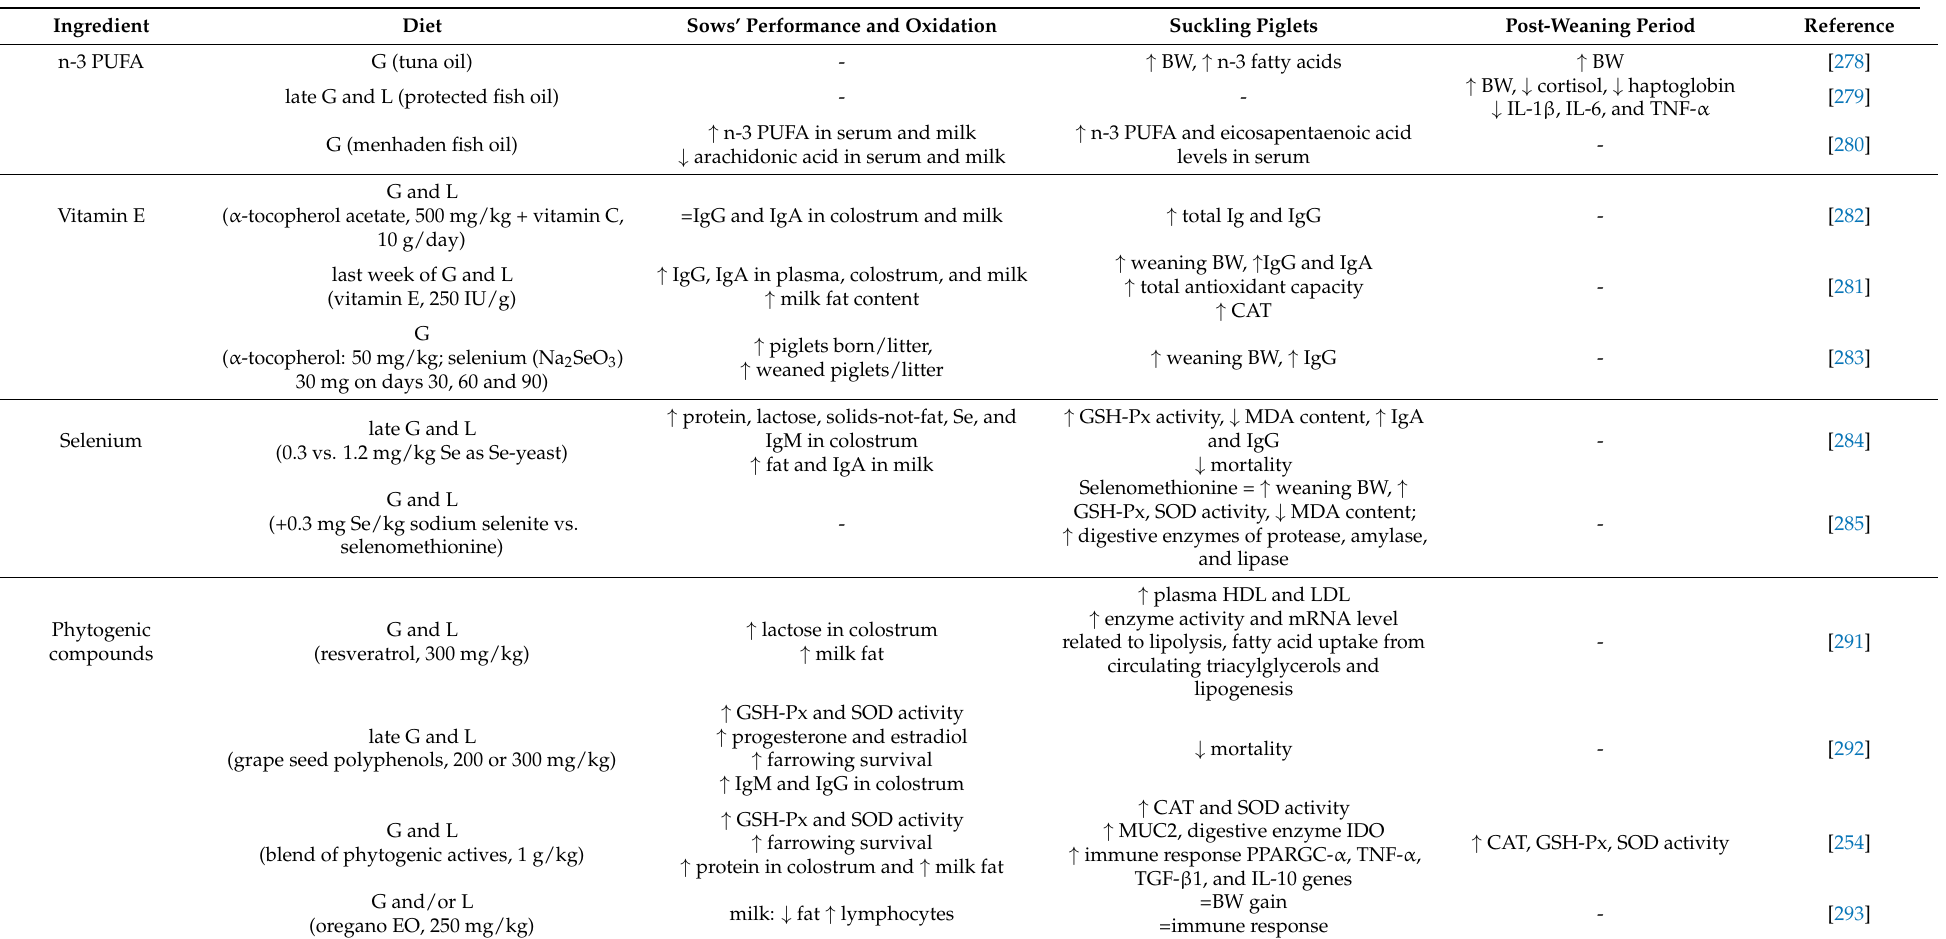
Table 6. Effects of fatty acids, vitamins, trace minerals, phytogenic compounds, and spray-dried plasma in the sow diet on the oxidation and performance of sows and piglets. Ingredient Suckling